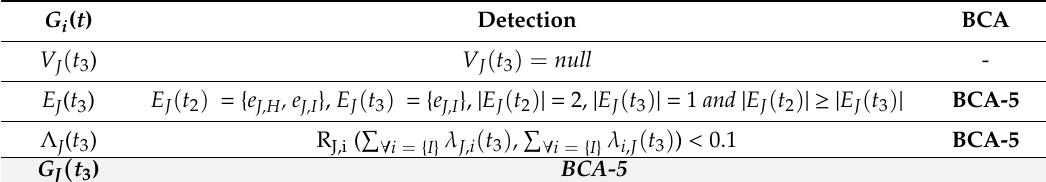
Table 12. BCA-5 detection on host J at t 3 during a redirection